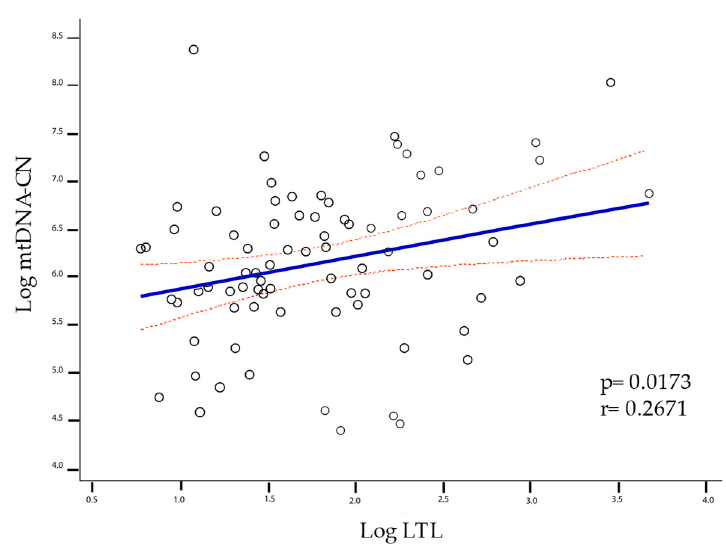
Figure 2. Linear correlation between LTL and mtDNA-CN was significant for all groups ( p = 0.0173, r = 0.2671). The solid line represents the regression line, and the dashed lines represent the confidence interval of 95%.